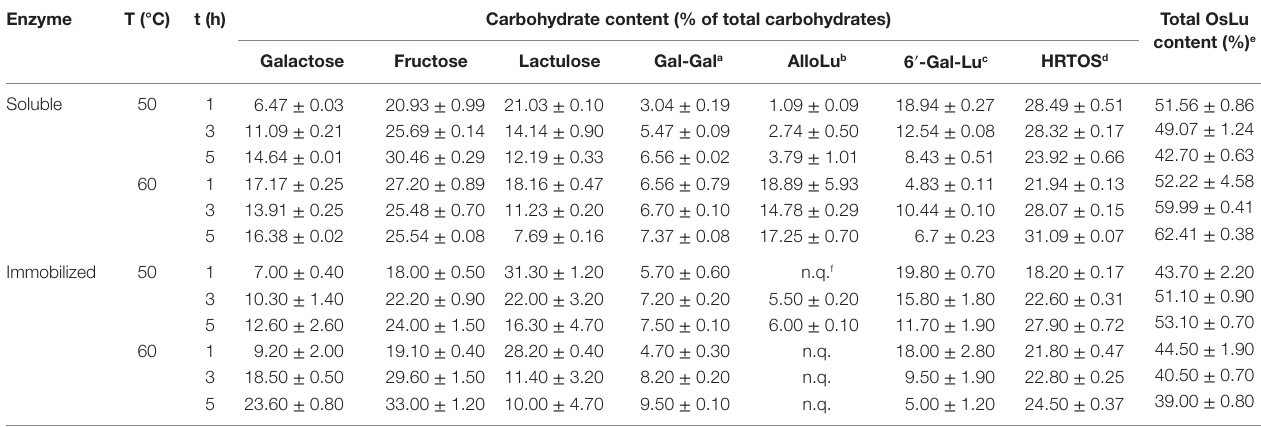
TaBle 1 | effect of temperature on the carbohydrate content present in the reactions mixtures during the hydrolysis of lactulose (450 g/l in 0.1 M buffer sodium phosphate at ph 6.5) using A. oryzae β -galactosidase in soluble form and immobilized (8 U/ml) on a support of glutaraldehyde–agarose. enzyme T (°c) t (h) carbohydrate content (% of total carbohydrates) galactose lactulose